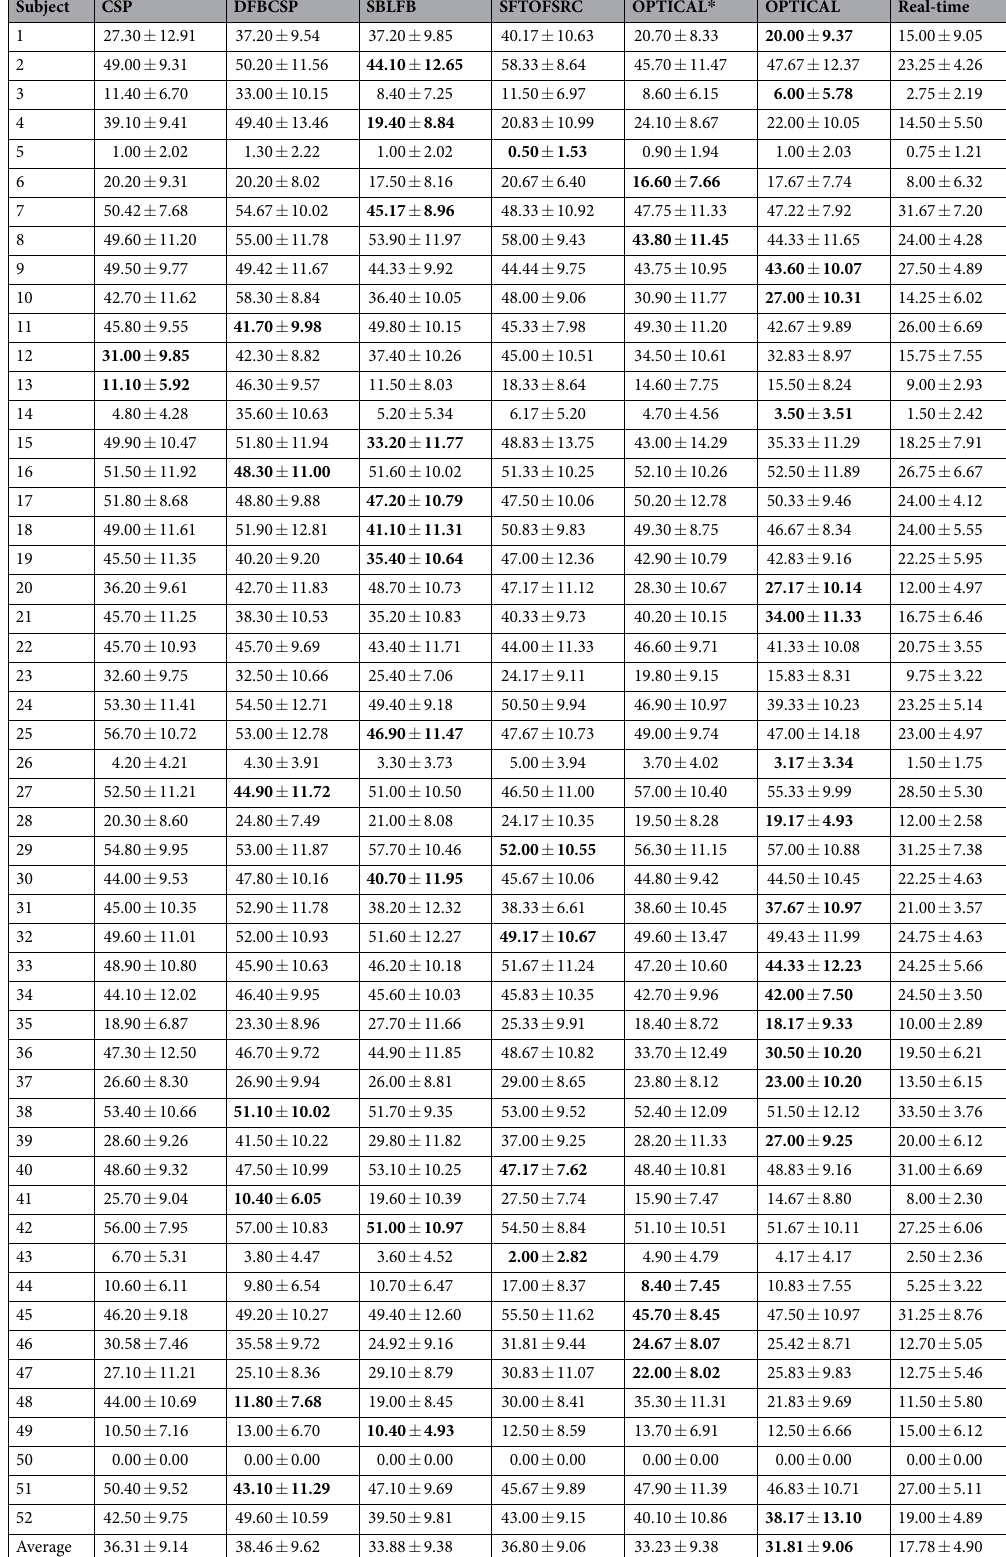
Table 2. Misclassification rate (%) of different methods evaluated using GigaDB